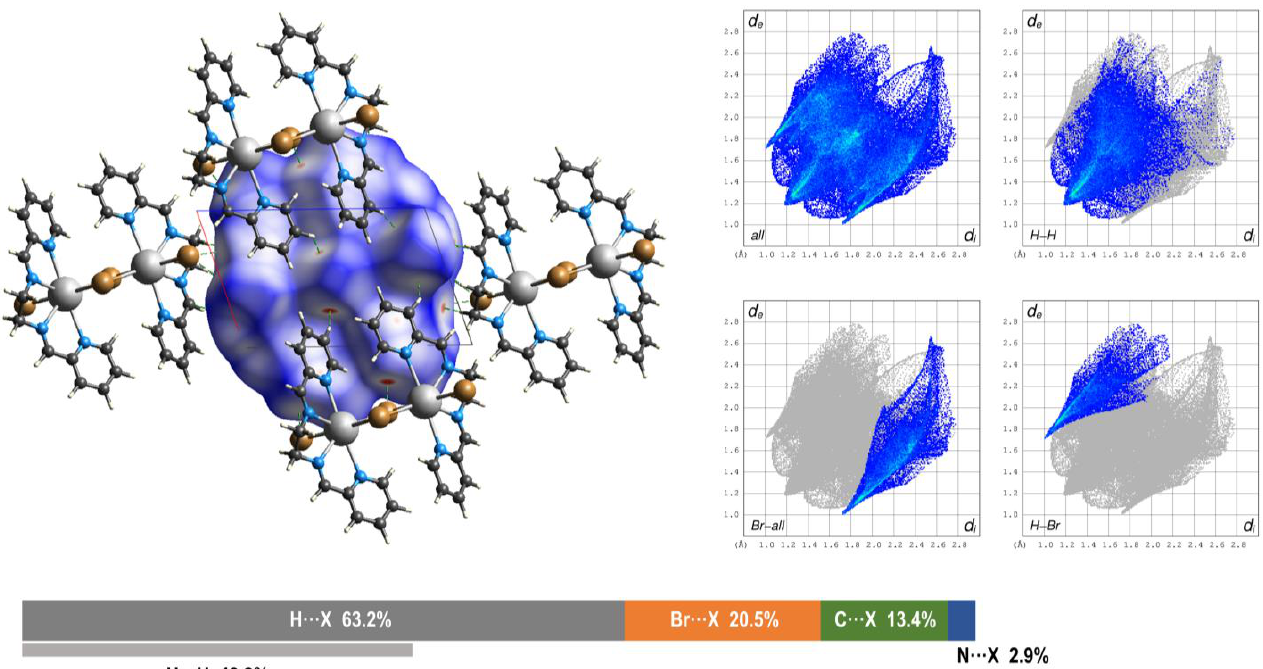
Figure 10. Left: Hirshfeld surface of the dinuclear molecule of 3 surrounded by the closest molecules (view along the b axis). Right: selected fingerprint plots of the respective surface. Bottom: contribu- tions (in %) of specific X i ···X e interactions.